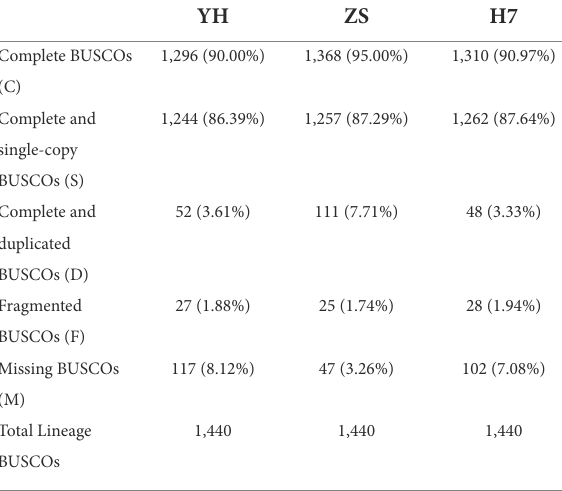
TABLE 3 Assessment of BUSCO notations in the C. mollissima